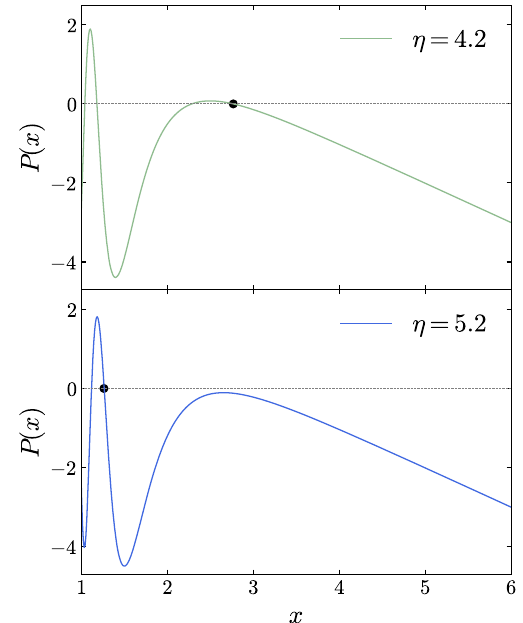
Fig. 1 P ( x ) for η = 4 . 2 (top) and η = 5 . 2 (bottom) are shown. The dimensionless radius of the photon sphere x m (denoted by black dot) jumps from about 2.5 (top) to about 1.2 (bottom)